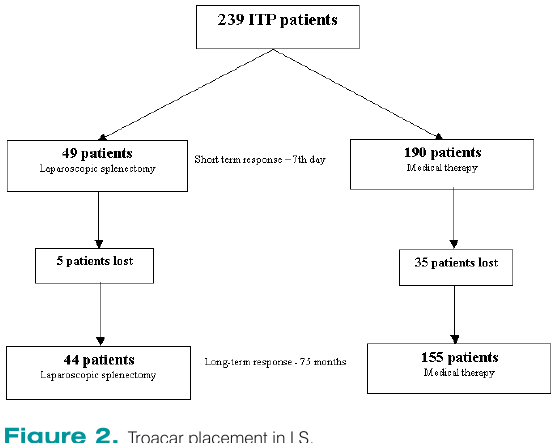
Figure 1. Patient’s research scheme.